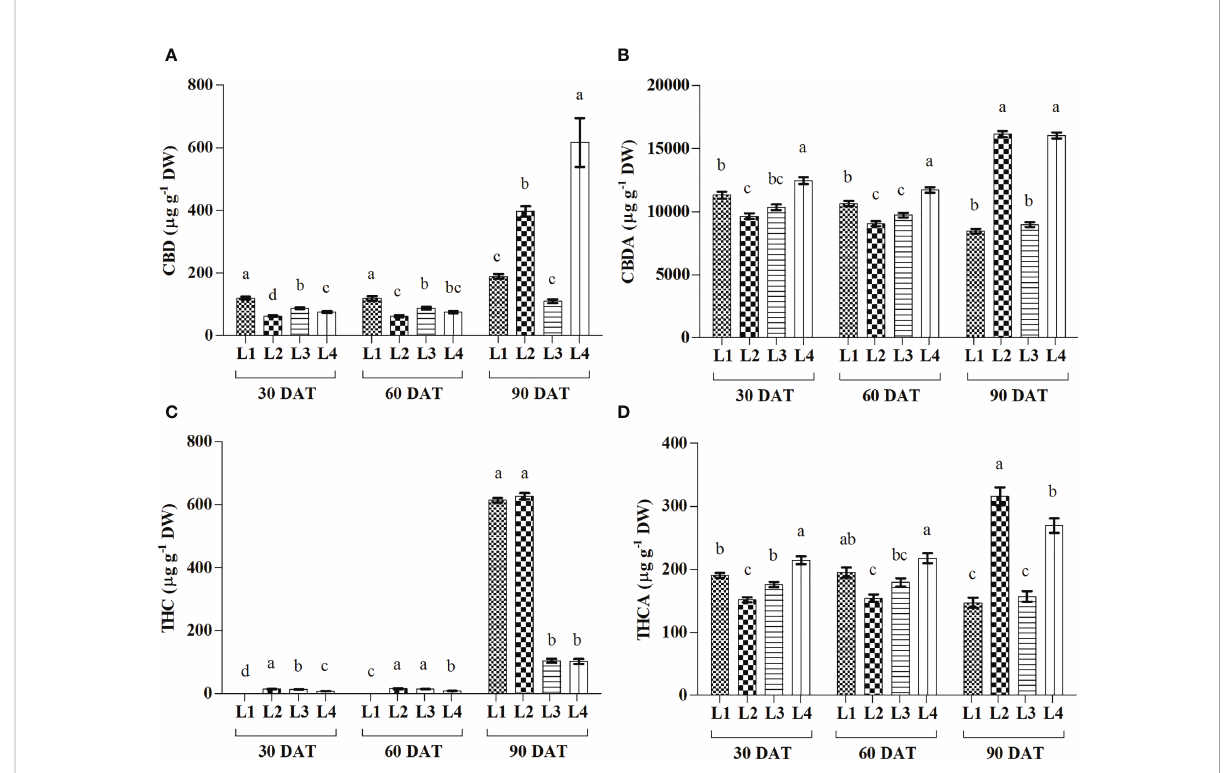
FIGURE 7 Effect of LED spectra on cannabidiol (CBD) (A) , cannabidiolicacid (CBDA) (B) , tetrahydrocannabinol (THC) (C) and tetrahydrocannabinolic acid (THCA) (D) of hemp seedlings at 30, 60, and 90 DAT. Here and subsequent fi gures: L1, MW 240 (Red 35% + Blue 25% + Green 40%); L2, FS 240-UV (Red 40% + UVA and Blue 26% + Green 29% + Far red 5%); L3, MB 240 (Red 85% + Blue 15%); L4, PF 240 (Red 70% + Blue 30%); ND, not detected. All treatments used a photosynthetic photon fl ux density of 300 µmol m − 2 s − 1 . Column height indicates the mean, vertical bars indicate the standard error of the mean (n = 4), and different letters indicate signi fi cant differences at p <